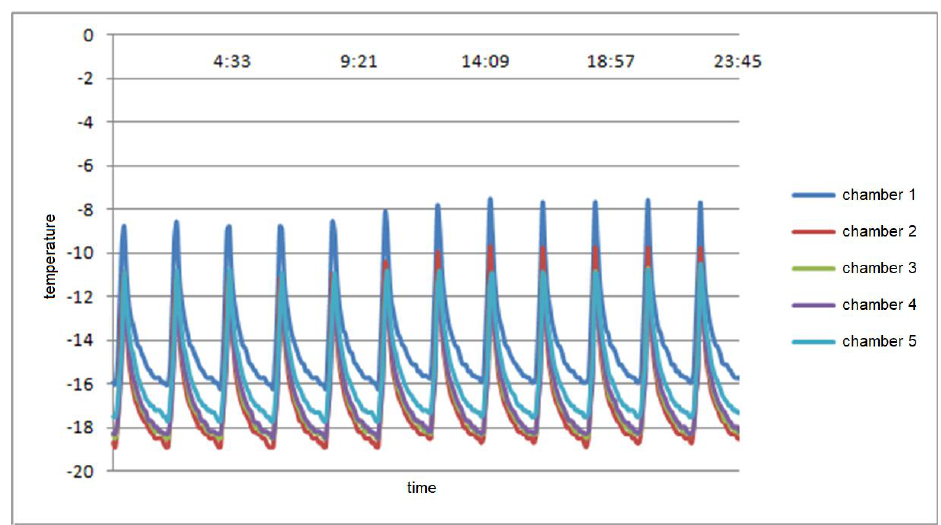
Figure 4. Temperature distribution in the cooling module chambers .